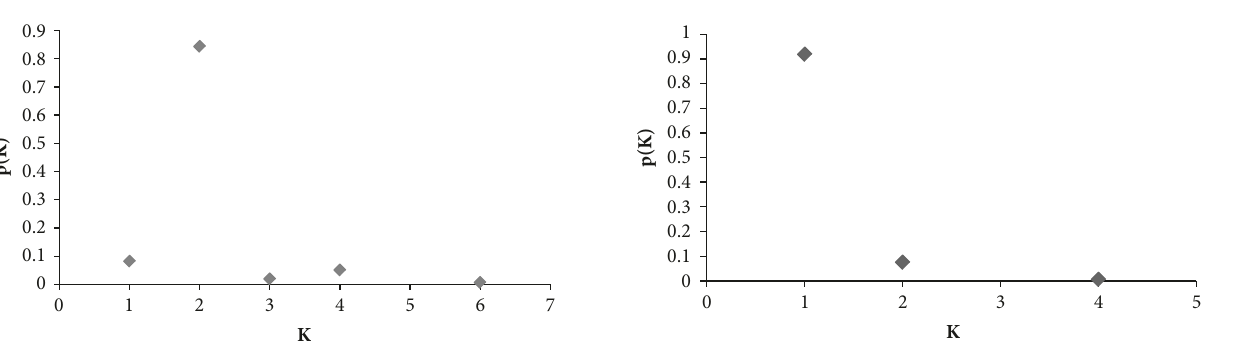
Figure 7: Probability distribution of hypernetwork node-hyperedge degree in Nanjing metro.